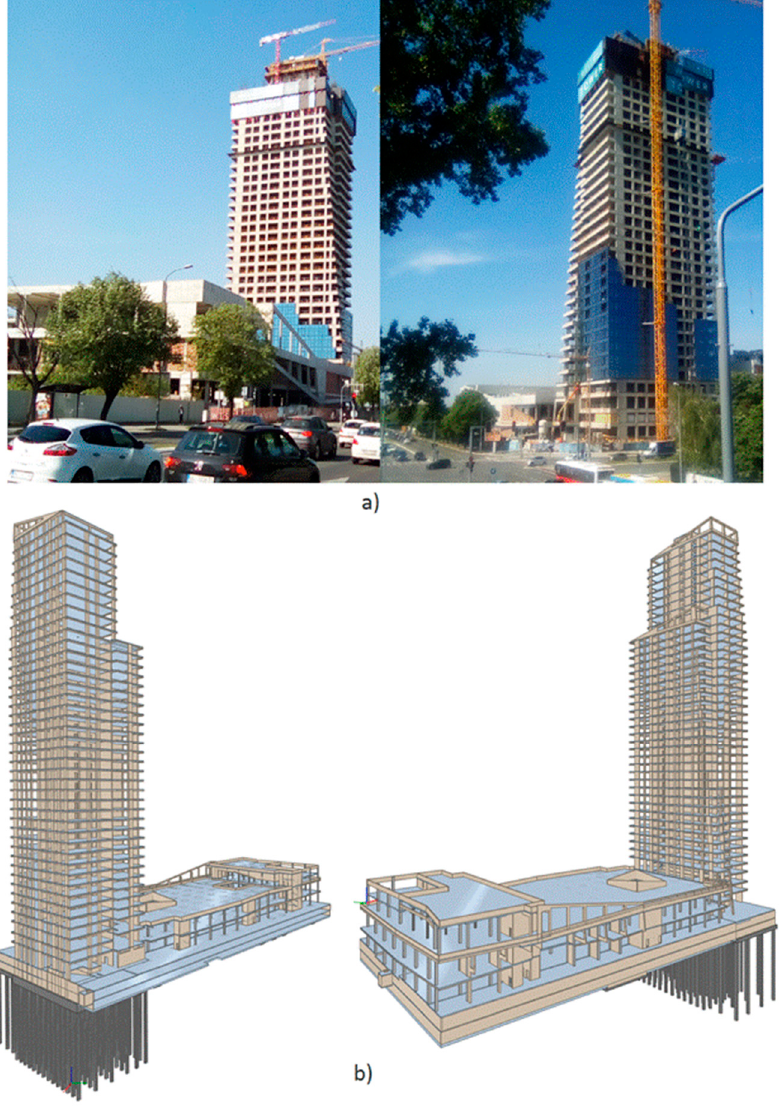
Figure 6. ( a ) Photo of the construction phase of the West 65 project ( b ) The model of the construc- tion project.